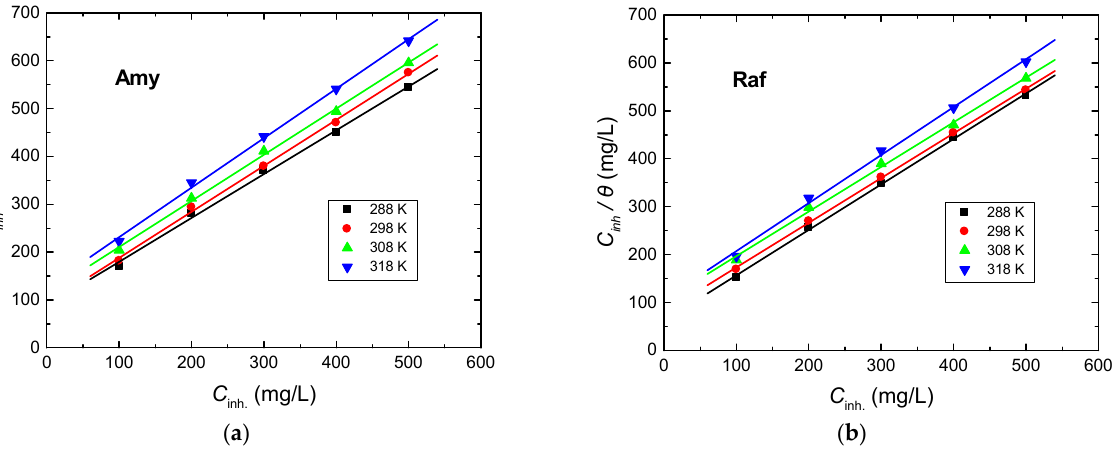
Figure 9. Langmuir adsorption isotherms for, ( a ) Amygdalin (Amy), and ( b ) Raffinose (Raf), adsorbed on the Al surface in 0.1 M NaOH medium at various temperatures. Table 5. Values of K ads and thermodynamic parameters for Al corrosion inhibition in 0.1 M NaOH medium by Amy and Raf at various